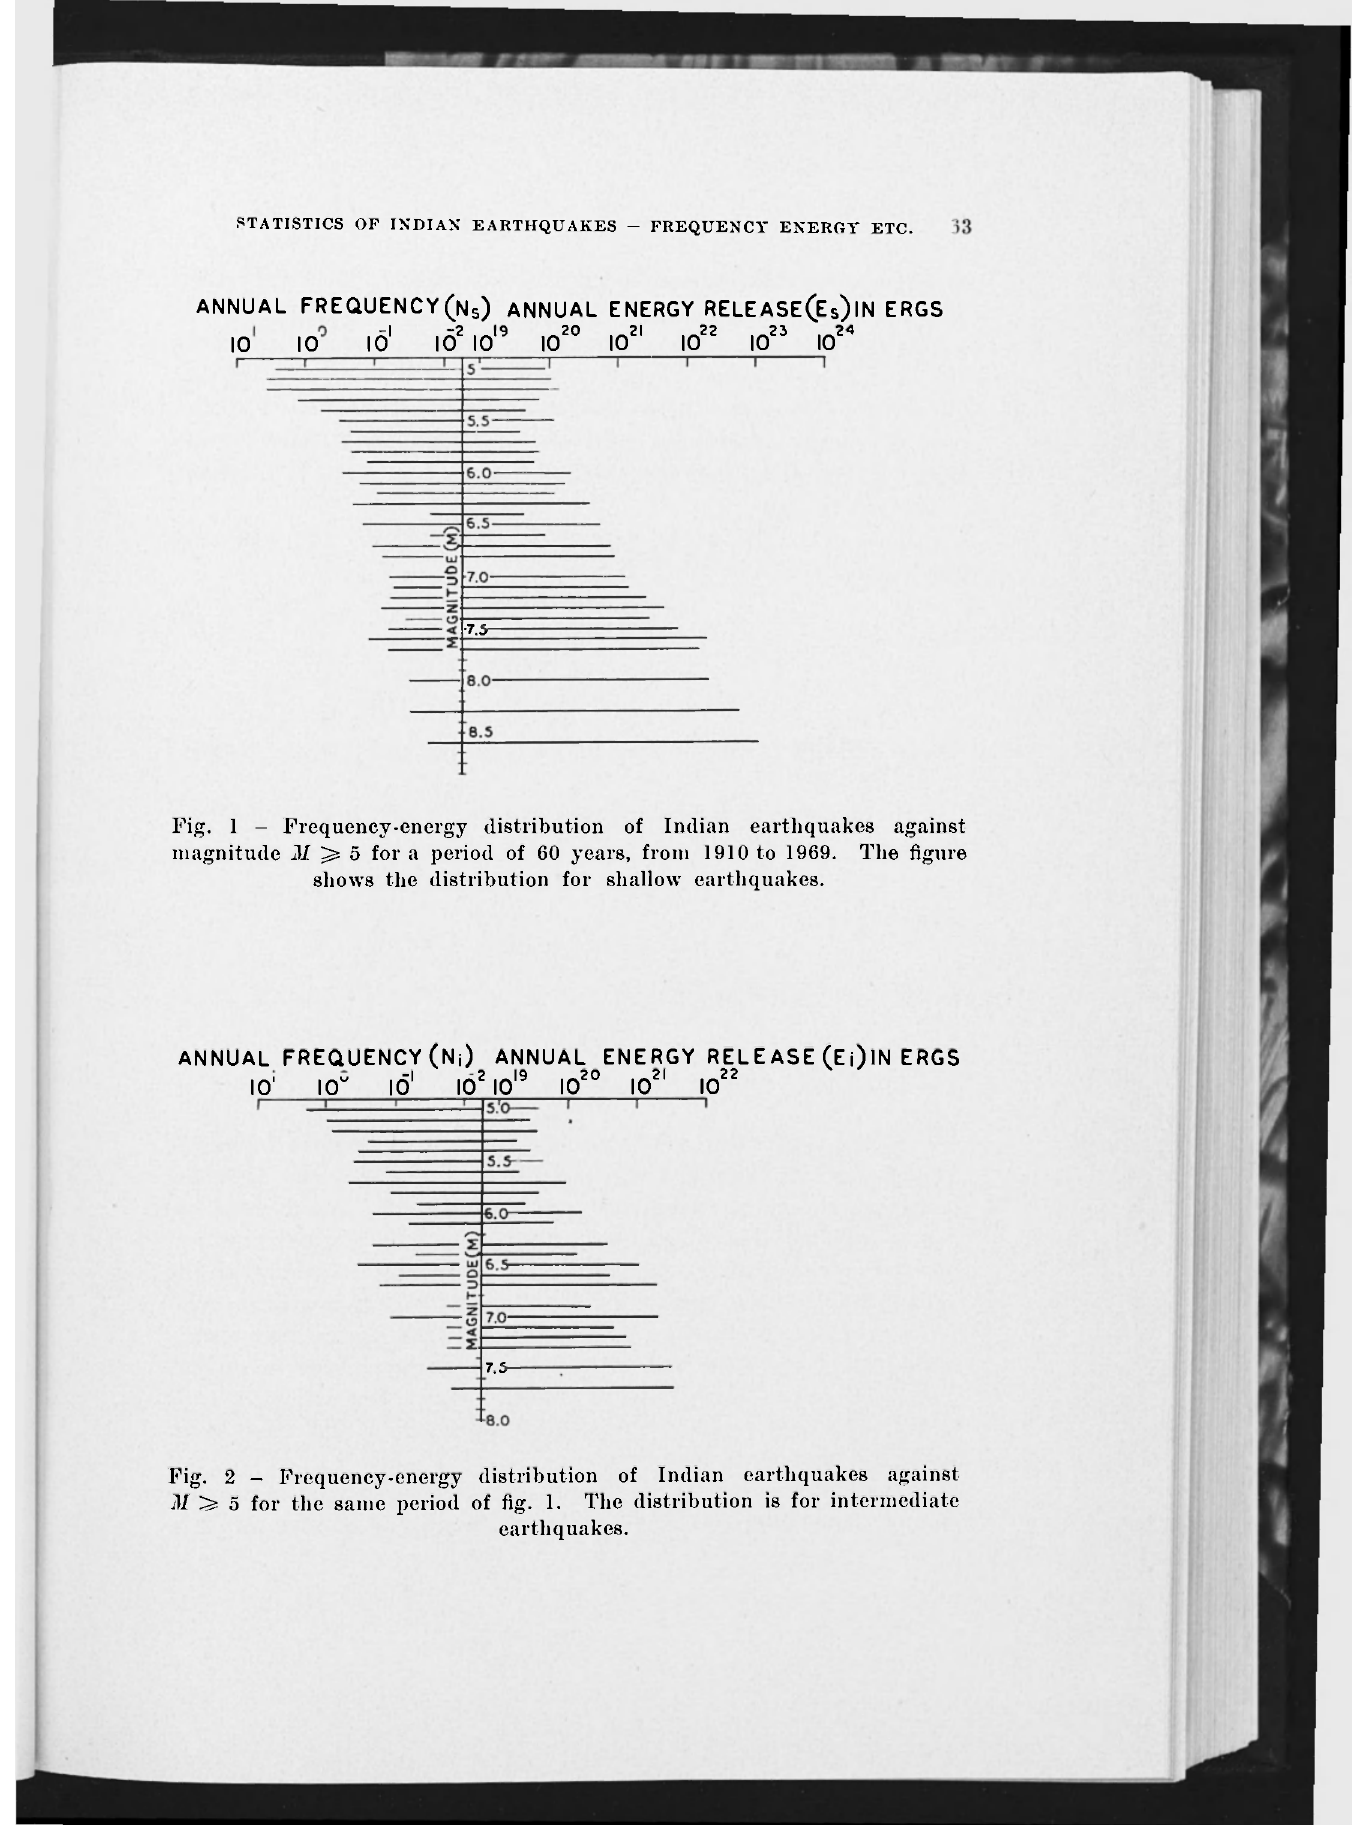
Fig. 2 - Frequency-energy distribution of Indian earthquakes against M 5 for the same period of fig. 1. The distribution is for intermediate